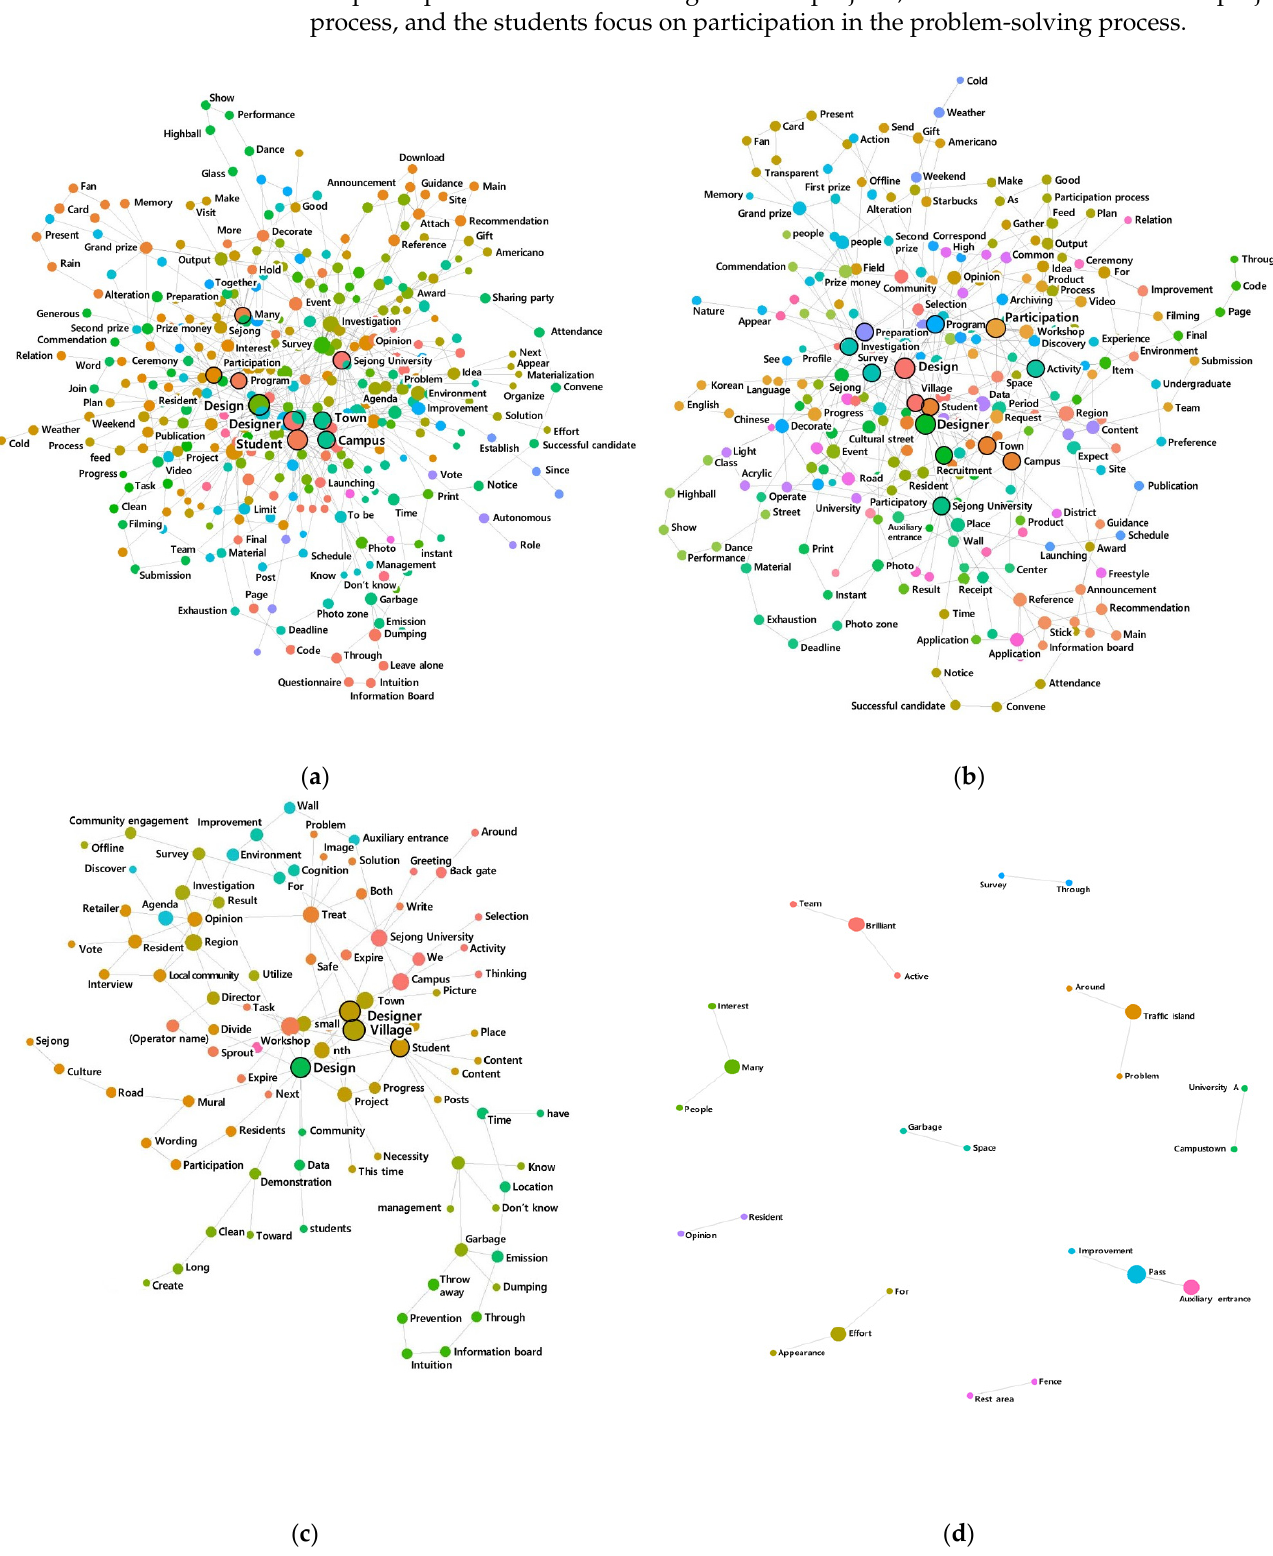
Figure 1. Network graph analysis: ( a ) total; ( b ) facilitators; ( c ) students; ( d ) residents.